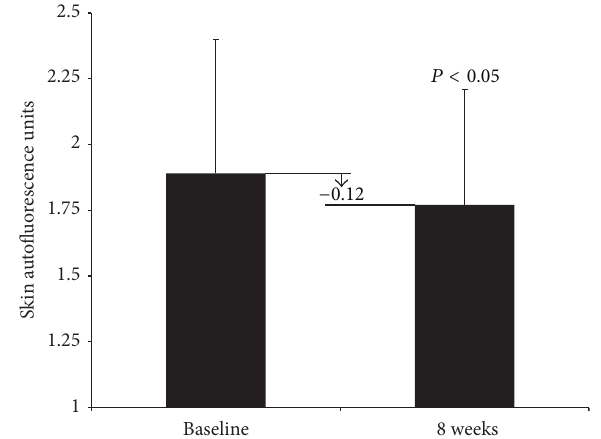
Figure 2: Baseline and week 8 mean skin autofluorescence units (with standard deviation) of 34 overweight adults who consumed daily a beverage containing food sources of iridoids. The average change in autofluorescence was − 0.12